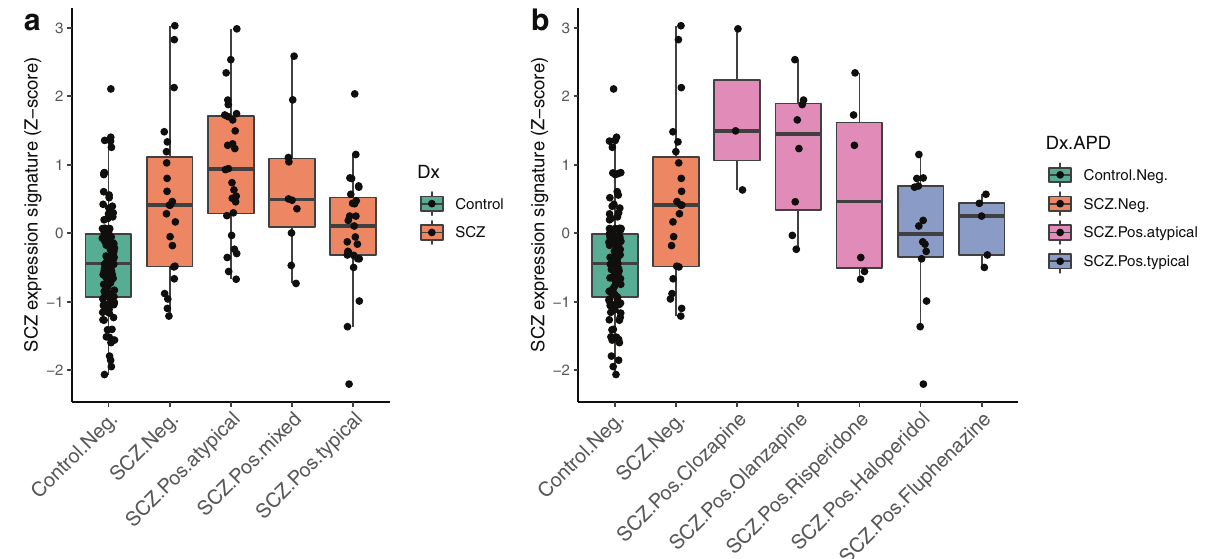
Fig. 1 SCZ-associated differential gene expression between toxicological subgroups. a Aggregated scores of differential gene expression (SCZ expression signatures) are shown based on toxicological fi ndings (Neg.: negative for any APD; Pos.: positive for atypical, typical, or both APD [mixed] classes). Kruskal – Wallis test (KWt) on all groups: p = 3.83e-10; KWt within SCZ subgroups only: p = 0.014. For details and post hoc Dunn tests, see Supplementary Table S2. b As in a but SCZ samples were divided into groups of 3 or more cases positive for a single APD (atypical APDs: clozapine [ n = 3], olanzapine [ n = 8], risperidone [ n = 6]; typical APDs: haloperidol [ n = 14], fl uphenazine [ n = 5]). SCZ expression signatures were based on gene expression values residualized for major in fl uential covariates, such as sex, age, RNA integrity, and postmortem interval (see “ Methods ” APD compound revealed that samples with clozapine and olanzapine had the highest SCZ expression signature, followed by samples with risperidone, fl uphenazine, and haloperidol (Fig. 1b). Similar results were obtained with the SCZ expression signature calculated based on the larger PsychENCODE dataset [2] (Supplementary Fig. S1) and in a smaller independent validation cohort with associated postmortem brain toxicology data from UC Irvine (Supplementary Fig. S2). Similarly, traditional differential gene expression analyses for SCZ subgroups showed that individuals with atypical APD exposure had the largest number of differentially expressed genes (Supplementary Table S1). These fi ndings show that transcriptional differences between SCZ cases and controls are larger in APD-positive cases, particularly those treated with atypical APDs. SCZ expression signatures are correlated with APD signatures in macaques Differential gene expression in the human brain can re fl ect both APD exposure and disease severity. To study the effects of APDs on gene expression in relative isolation, we used published transcriptome data from the DLPFC of healthy rhesus macaques treated with either clozapine, haloperidol, or placebo [11]. While the differential gene expression analysis did not yield any genes that passed a false discovery rate (FDR) threshold of 5%, a gene ontology analysis of the top nominally signi fi cant genes did show signi fi cant enrichment of terms related to immunological pro- cesses, metabolism, and synaptic transmission (Supplementary Fig. S3 and Supplementary Table S3). These functional enrich- ments are also similar to those previously found for haloperidol and clozapine in rodent forebrain tissue [12, 13]. A direct comparison between mouse and macaque APD effects showed high concordance for haloperidol and low but signi fi cant concordance for clozapine (Supplementary Fig. S4). To harness information across conserved, functionally relevant gene co-expression networks, we applied signed consensus WGCNA [14] across the macaque and human datasets. We identi fi ed 37 consensus modules. Relationships of these modules